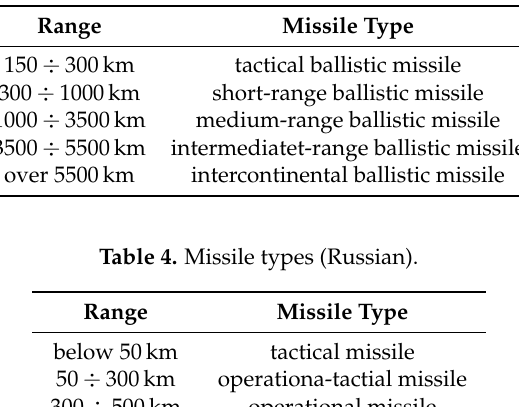
Table 3. Missile types (American).